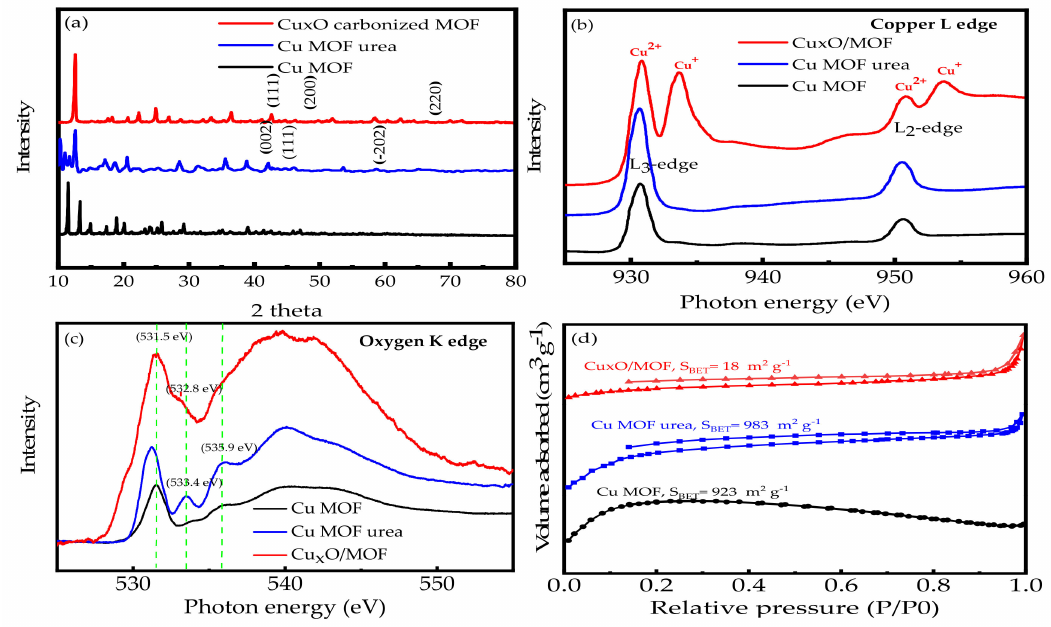
Figure 2. ( a ) XRD patterns and, ( b ) copper L-edge and ( c ) oxygen K edge XAS spectra and ( d ) N 2 adsorption-desorption curves of the surface area of Cu-MOF, Cu-MOF-urea, and Cu x O/MOF after carbonization at 300 ◦ C, in the presence of Ar/H 2